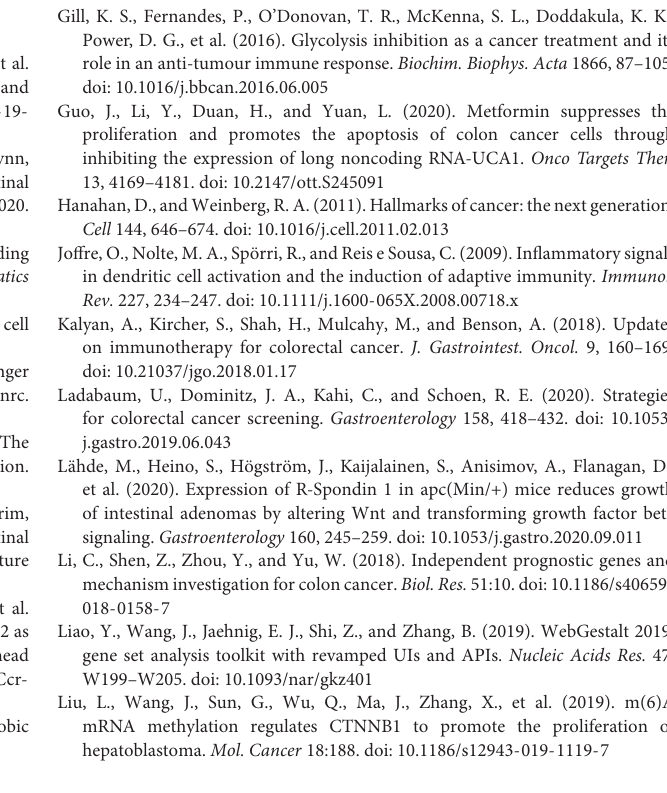
Supplementary Figure 1 | Identification of GRGs. GSEA identification of five gene sets that are significantly enriched, including Biocarta Glycolysis Pathway, Glycolytic Process, Hallmark Glycolysis, KEGG Glycolysis Gluconeogenesis, and Reactome Glycolysis. Supplementary Figure 2 | Relationship of GRGs signature with clinicopathological characteristics in GSE17536. (A) Box plots showing risk score distribution of different clinical characteristics of COAD tumors in GSE17536 cohort. (B) GRGs risk model is of good value in predicting the OS rate of patients with colon cancer in multiple clinical subgroups. Supplementary Figure 3 | Expression of the eight signature GRGs in online databases. (A) UALCAN online database (http://ualcan.path.uab.edu/) expression of eight glycolysis related genes in TCGA. (B) GEPIA online database (http://gepia.cancer-pku.cn/) expression of eight glycolysis related genes in TCGA and GTEx. Supplementary Figure 4 | Evaluation of eight glycolysis genes on the prognosis of colon cancer. Supplementary Table 1 | Primer sequences of eight glycolysis related genes. Supplementary Table 2 | GO analysis of genes involved in differential glycolysis. Supplementary Table 3 | Analysis of related KEEG pathways involved in differential glycolysis genes. Supplementary Table 4 | Glycolysis related genes are differentially expressed in colon cancer